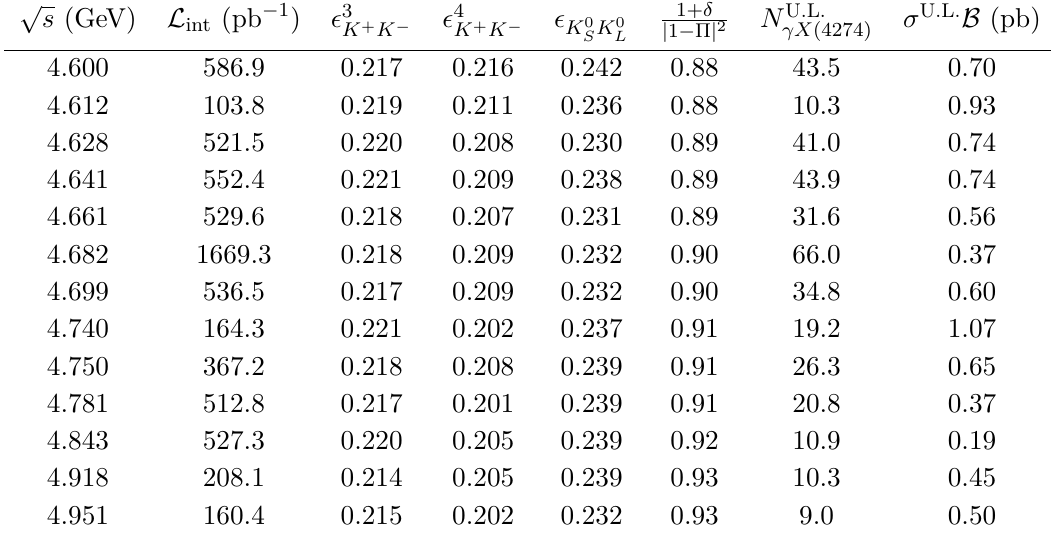
Table 10 . The upper limit of Born cross section at 90% C.L. σ U . L . B ( X → φJ/ψ ) for e + e − → √ γX (4274) at each c.m. energy s . The table also includes integrated luminosity L int , detection efficiency (cid:15) 3 , (cid:15) 4 and (cid:15) for the 3-track events in the φ → K + K − mode, 4-track events K 0 K 0 K + K − K + K − S L in the φ → K + K − mode and the events in the φ → K 0 K 0 mode, respectively, the product of S L radiative correction factor and vacuum polarization factor 1+ δ and the 90% C.L. upper limit of | 1 − Π | 2 the number of fitted events for γX (4274) N U . L . γX (4274)